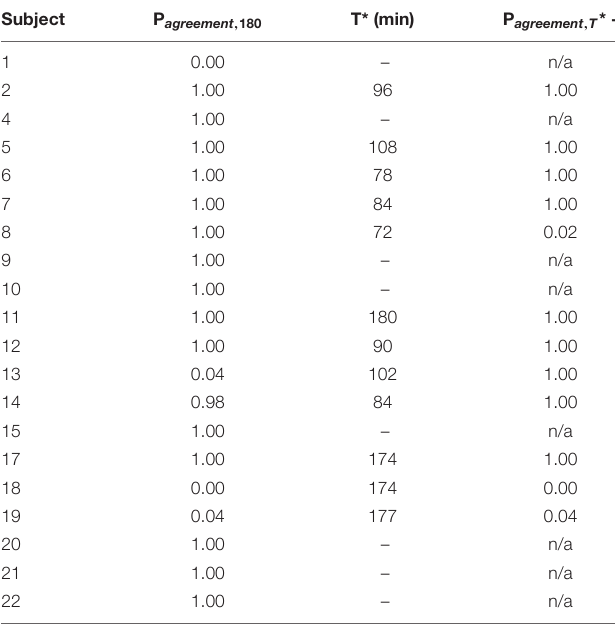
TABLE 4 | Results of quantitative validation